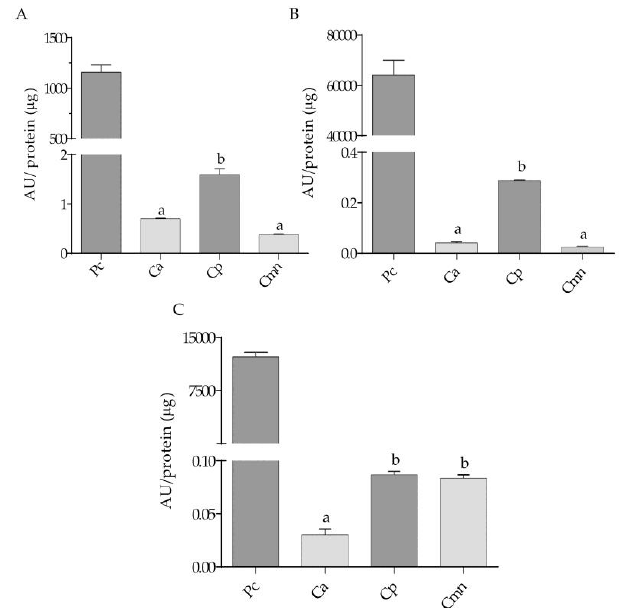
Figure 2. Protein pattern by SDS-PAGE, and Serine proteases zymography for C. aquilus (Ca), C. polystictus (Cp) and C. molossus nigrescens (Cmn) venoms. ( A ) 10% SDS-PAGE and ( B ) zymography. Trypsin-like zymography was performed using 50 µ g of venom samples protein with BApNA substrate. Chymotrypsin-like zymography was determined using 100 µ g of venom protein with SAAFpNA substrate. After electrophoresis, a cellulose membrane with each serine protease was placed on top of the gel and incubated for 5 h and 2.5 h at 37 °C, respectively. MWM: molecular weight markers (kDa). Variability in proteases bands is marked with red boxes.